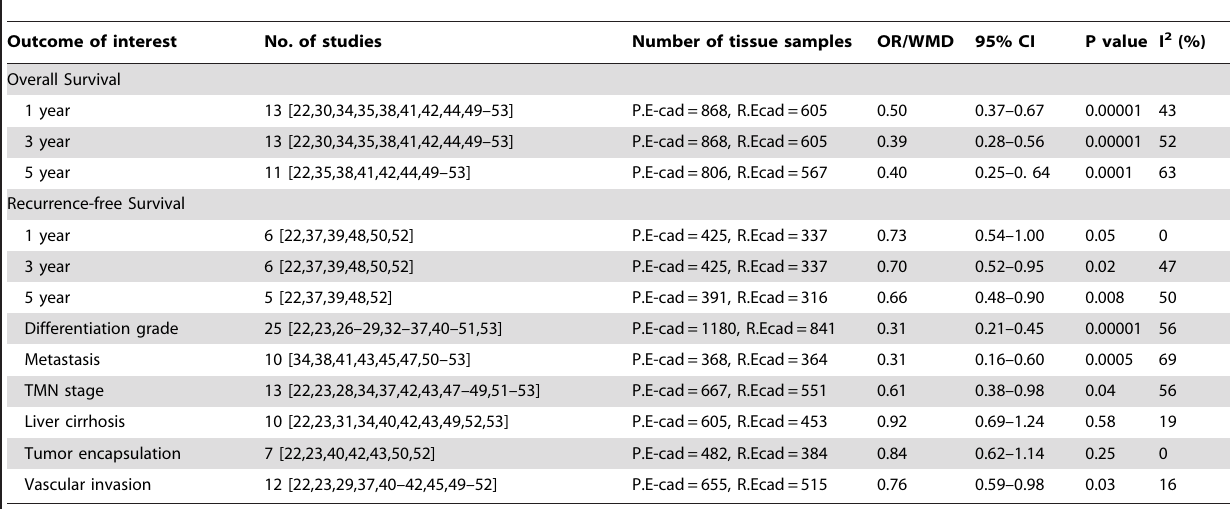
Table 2. Results of a meta-analysis comparing HCC with reduced E-cadherin and preserved E-cadherin.